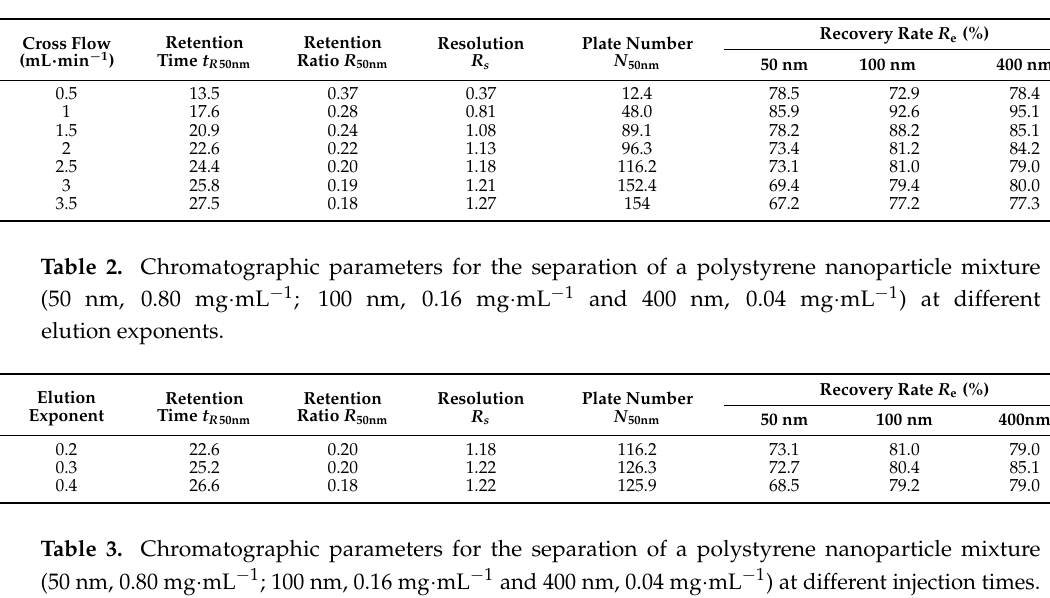
Table 1. Chromatographic parameters for the separation of a polystyrene nanoparticlemixture